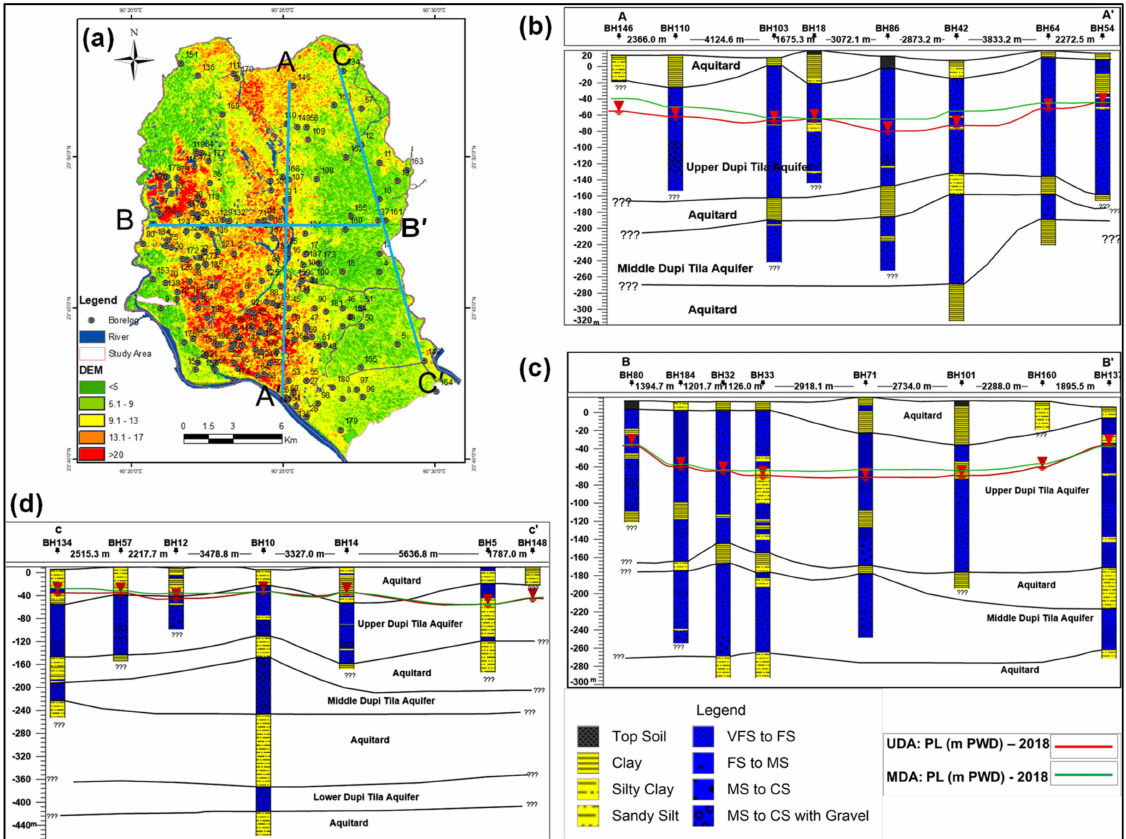
Figure 5. ( a ) Digital elevation model (DEM) map [81] showing the location of 188 boreholes with lithologs, along with the orientation of the cross-section lines in the study area. ( b ) N-S (AA (cid:48) ) trending hydrostratigraphic cross section with PL_2018. ( c ) W-E (BB (cid:48) ) trending hydrostratigraphic cross section with PL_2018. ( d ) NE-SE (CC (cid:48) ) trending hydrostratigraphic cross section with